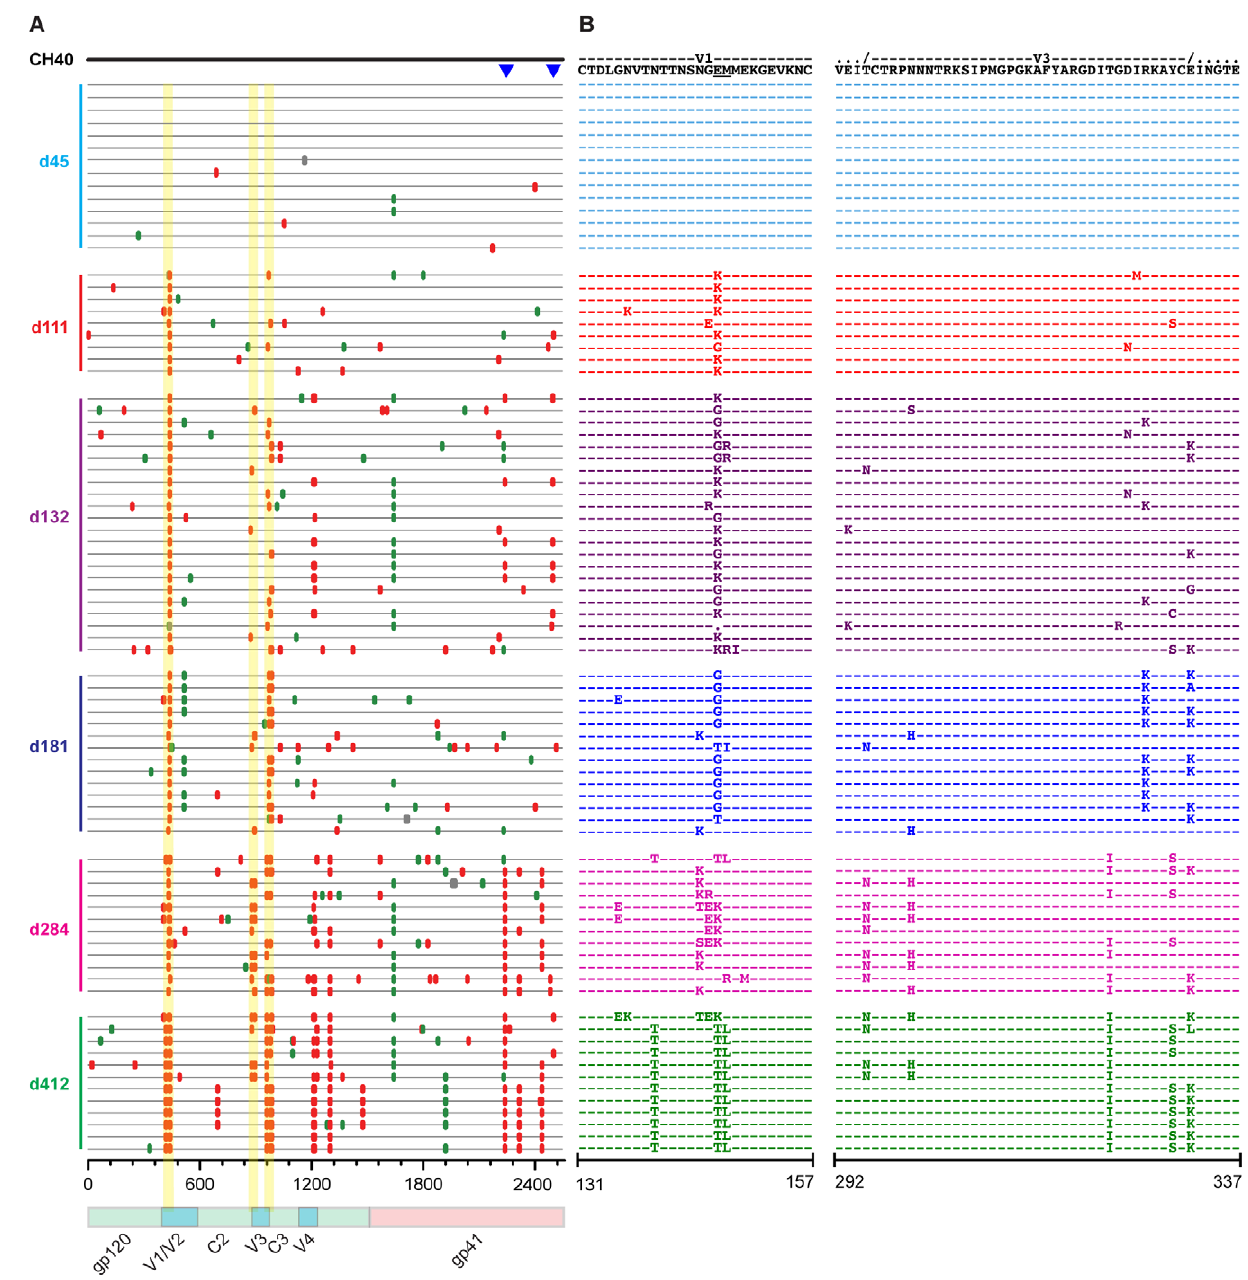
Figure 2. Highlighter analysis and env sequence alignments of putative Nab epitopes in subject CH40. A. Highlighter plot traces acquired mutations in gp160 env against the T/F sequence at top. Nucleotide differences from the T/F sequence are indicated (red: non-synonymous, green: synonymous) according to days post-seroconversion. CTL epitopes previously confirmed in T cell assays, are indicated by blue triangles. Mutations responsible for Nab escape are highlighted in yellow. B. Amino acid alignments of the V1 and V3 regions (HXB2 numbering). The two amino acid span interrogated by PASS is underlined. SGA sequences were from 6 independent experiments.